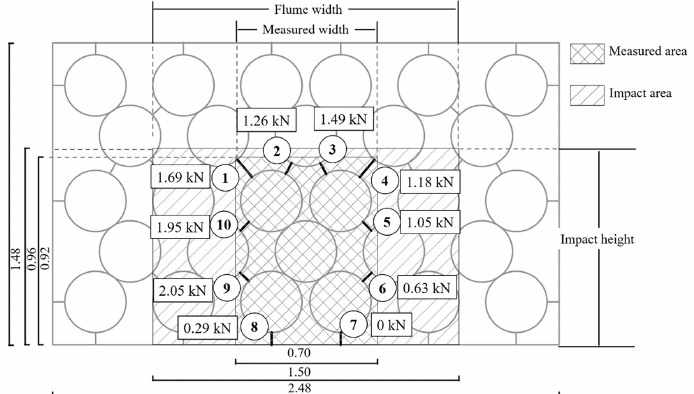
Figure 12. Sketch of the impact and measured area in test 1 and the maximum tensile forces measured from 10 mini tension link transducers under the impact of the granular flow (unit: m).